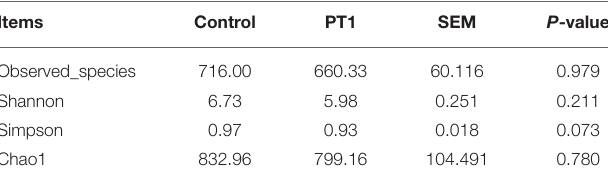
TABLE 6 | Alpha diversity of cecal microbiota.